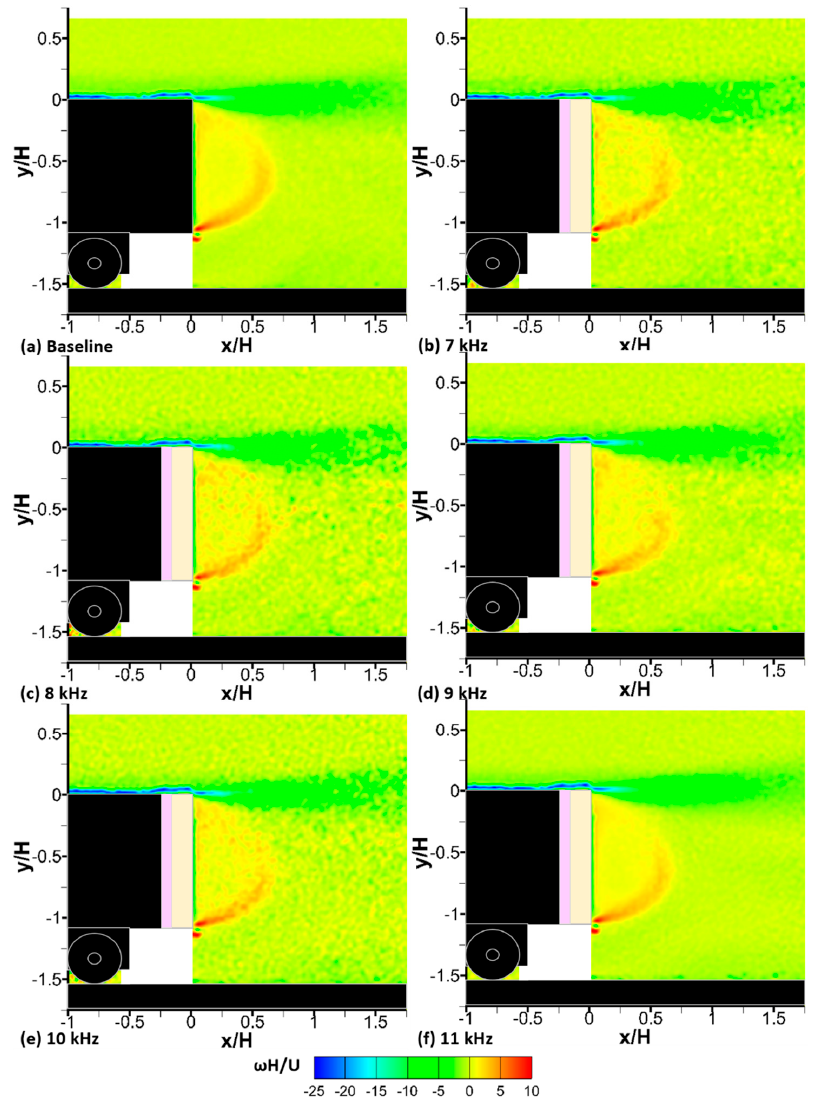
Figure 16. Normalised z-vorticity downstream of the trailer rear end at various plasma actuation frequencies. ( a ) Baseline, ( b ) 7 kHz, ( c ) 8 kHz, ( d ) 9 kHz, ( e ) 10 kHz, and ( f ) 11 kHz.